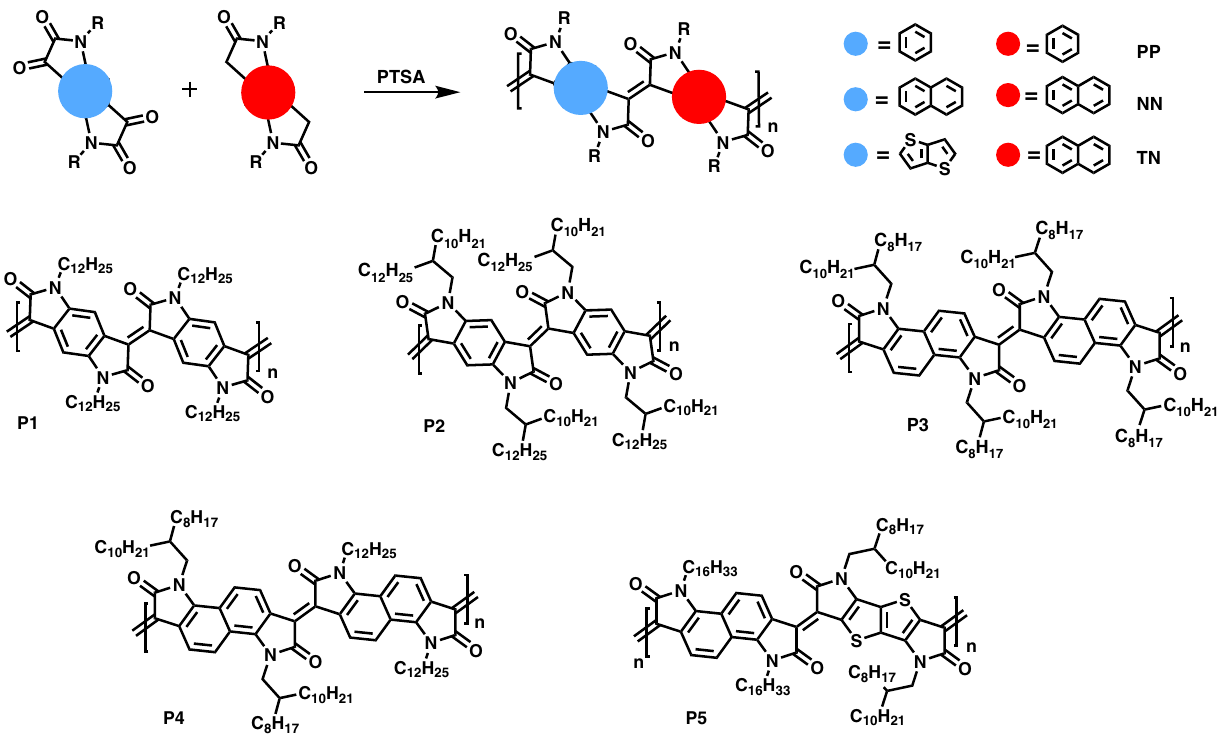
Fig. 1 The generic scheme for the preparation of rigid polymers synthesised via aldol polymerisation. The polymers are made from bis-isatin and bis- oxindole monomers. The aldol condensation polymers reported here are P1, P2, P3, P4 and P5. The polymer repeat units are described as PP for phenyl homopolymer, NN for naphthalene homopolymer and TN for thieno[3,2-b]thiophene and naphthalene copolymer. R is a solubilising alkyl